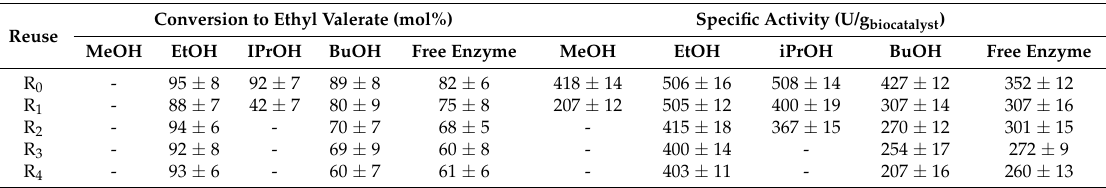
Table 6. Reusability studies of biosilicified enzymes for esterification reactions with different alcohols under CH.